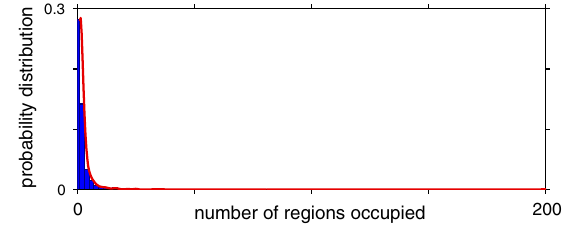
FIG. 10. Probability distribution for the number of different administrative regions occupied by the 822 “ new ” clans that are in the 2000 census data but are not in the 1985 census data. The solid curve is a kernel density estimate (from M ATLAB R2011a ’ s KSDENSITY function withaGaussiansmoothingkernelofwidth1).